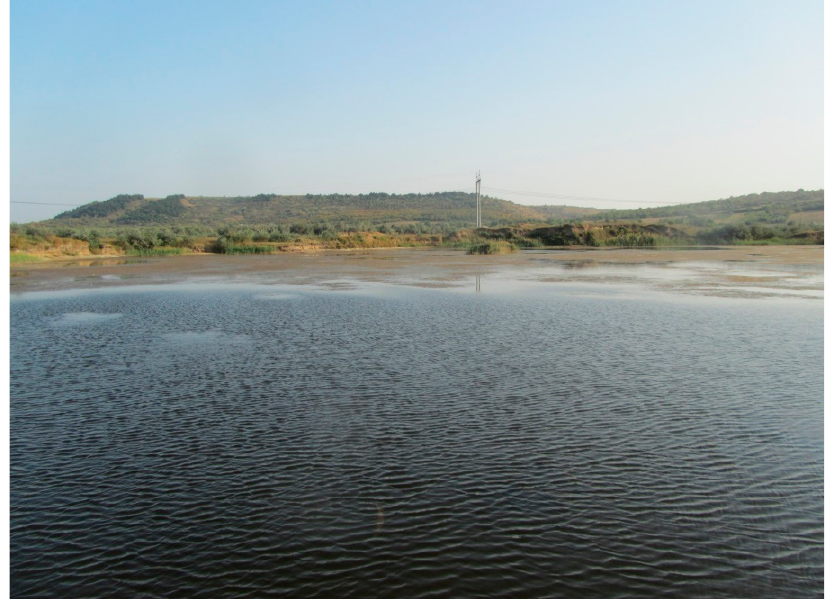
Figure 13. The water-filled sand quarry in which an overgrowing of higher aquatic and coastal vegetation began (surroundings of Adamivka village).